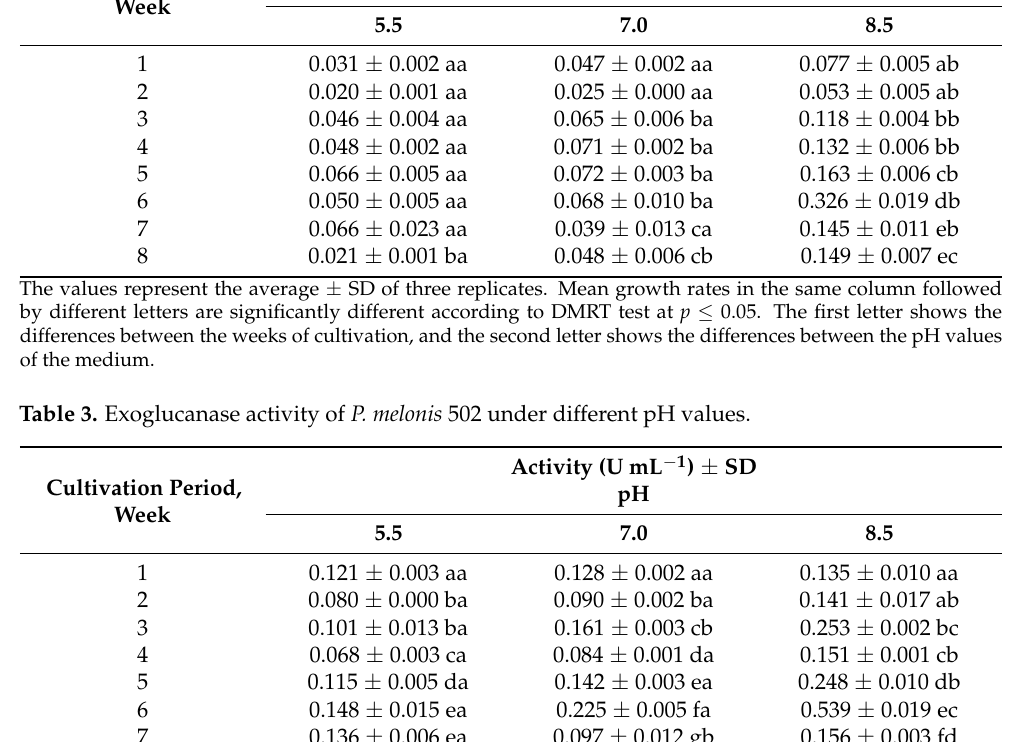
Table 2. Total cellulase activity of P. melonis 502 under different pH values. Cultivation Period,